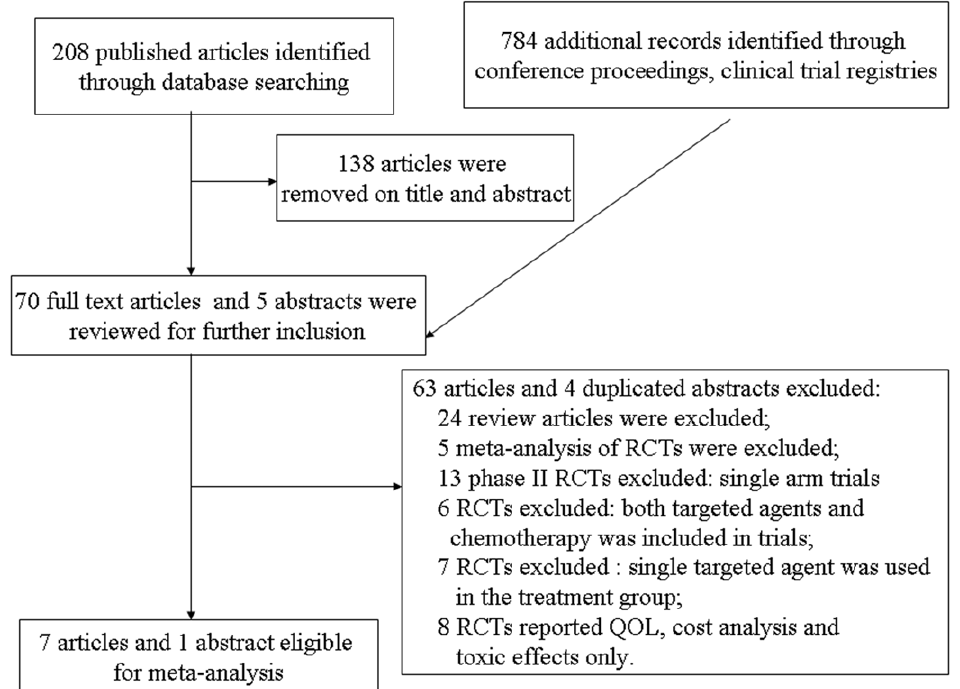
Figure 1. Flow chart of trial selection process.